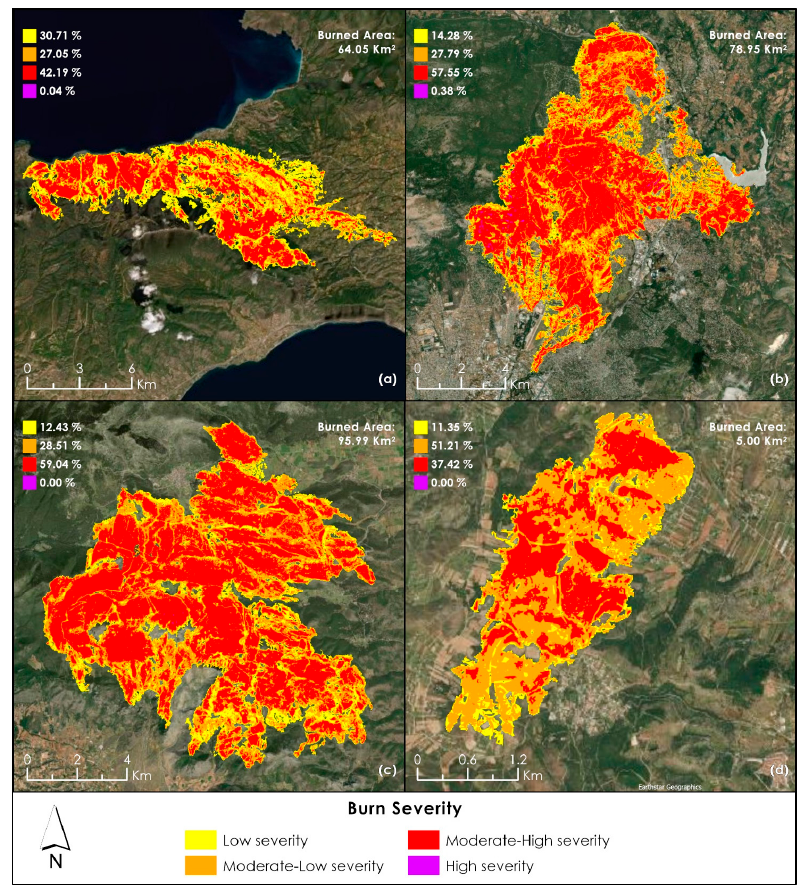
Figure 3. Burn Severity of 2021 Attica region wildfires: ( a ) Schinos; ( b ) Varympompi; ( c ) Vilia; ( d ) Lavreotiki. The burned area classification based on burn severity is illustrated including the percentage of the burned area total of each area per class.